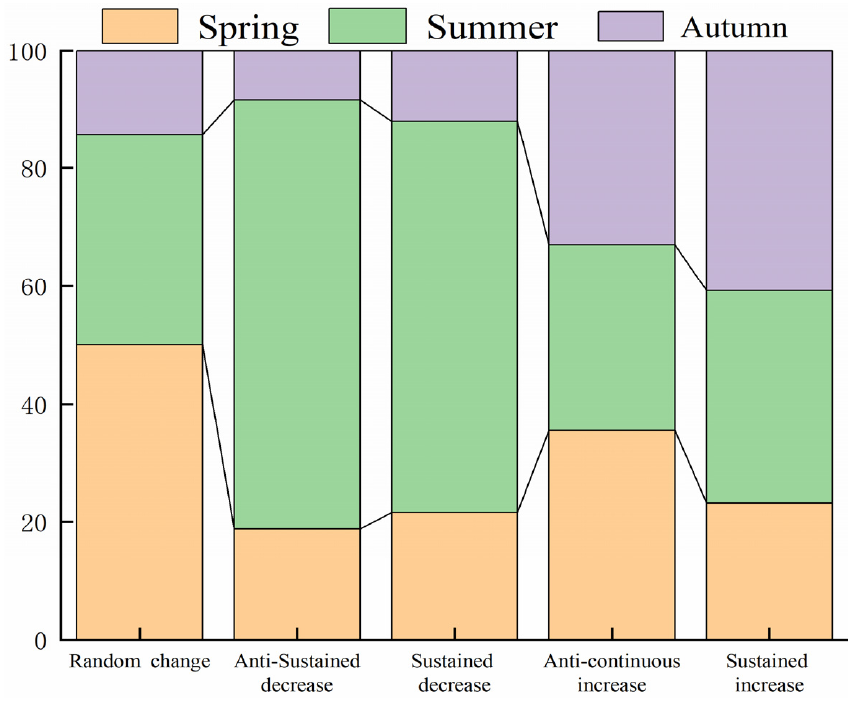
Figure 4. Proportion of future variation trend of vegetation NDVI in different seasons.